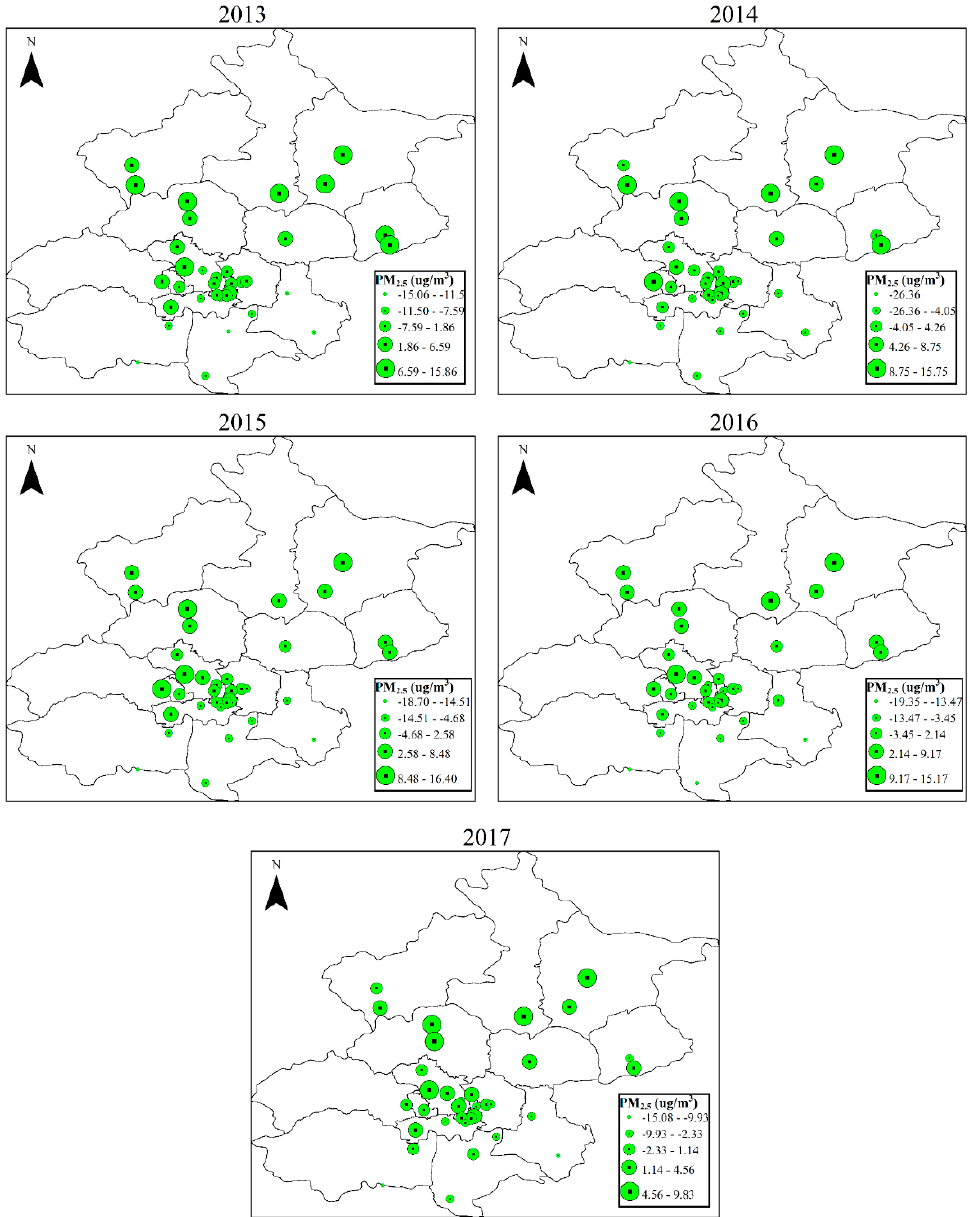
Figure 7. The differences between estimated and measured PM 2.5 ( µ g/m 3 ) at each monitoring site during 2013–2017.